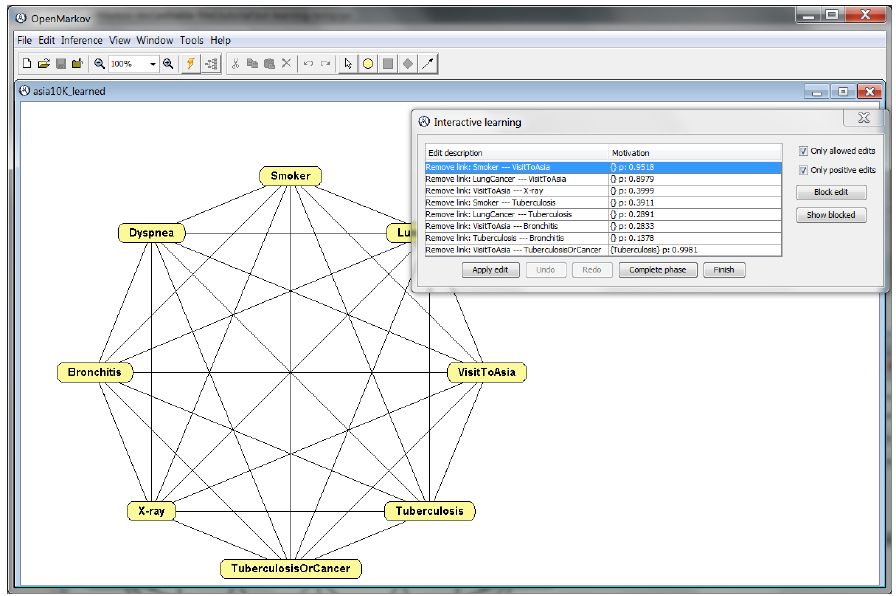
Figure 5. Initial state of the interactive PC algorithm when applied to the same dataset as in the previous figure. The “Motivation” column shows, for each edit, the p -value obtained for the test of independence conditioned on the variables in curly